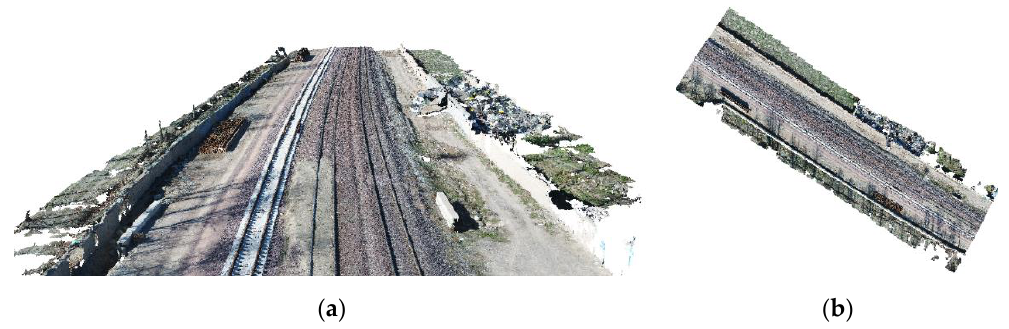
Figure 4. UAV-based point cloud from ( a ) the perspective view and ( b ) top view.